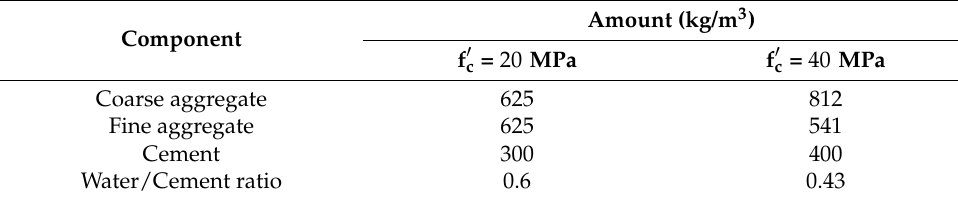
Table 1. Composition of the concrete mixture [48].